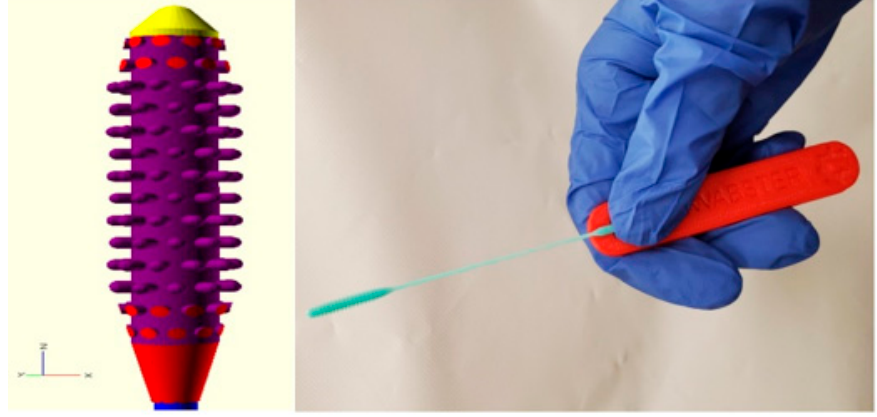
Figure 8. CAD representation and SLS-printed NP swab [64], open access.